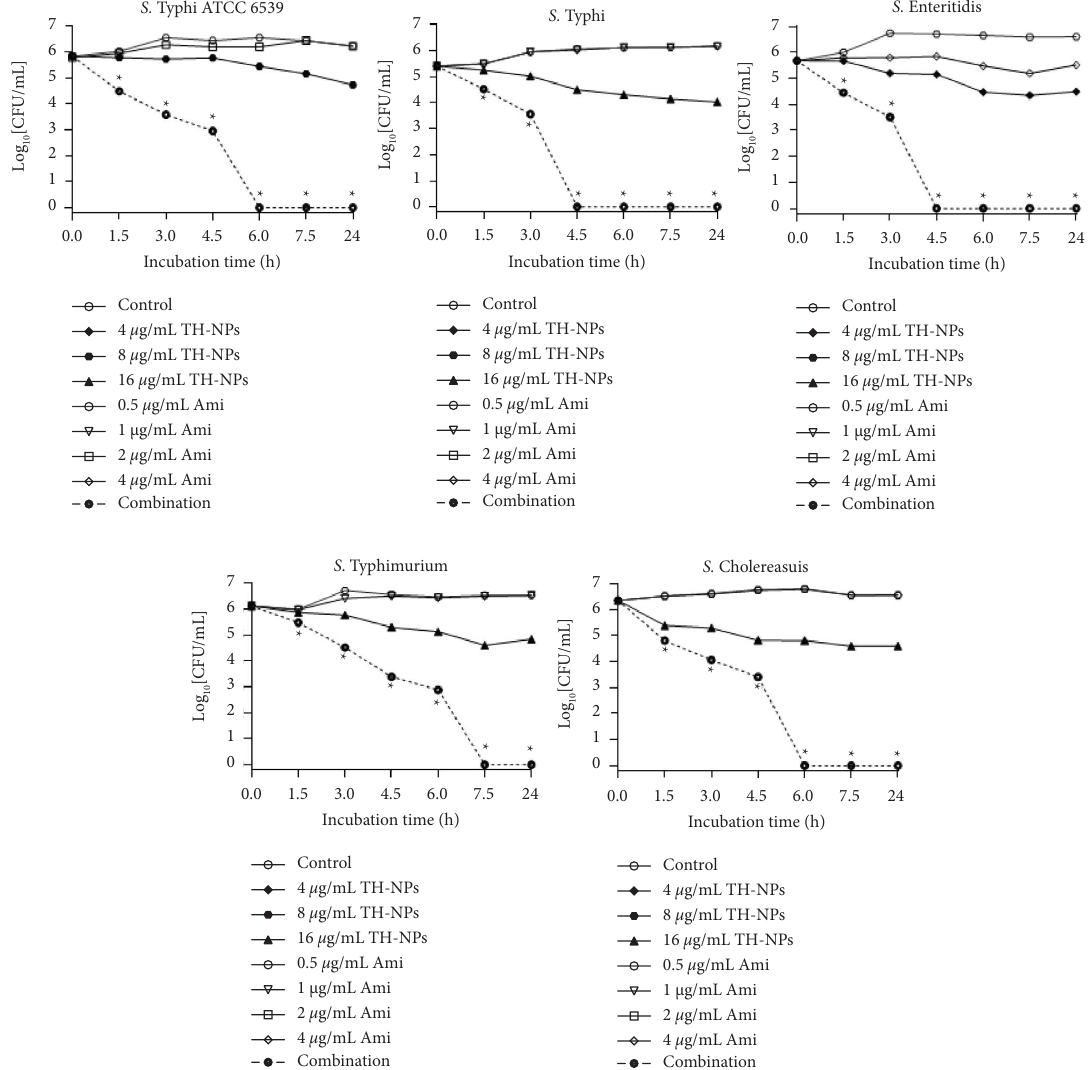
Figure 5: Time-kill kinetic assay of TH-NPs and amikacin alone or in combination against disruption of preformed bioflm of S.enterica serovars. TH-NPs: thymol-loaded PLGA nanoparticles; Ami: amikacin. Data represent the average values and standard deviation of three independent experiments. ∗ Signifcant diference between the combination and TH-NPs alone ( p <